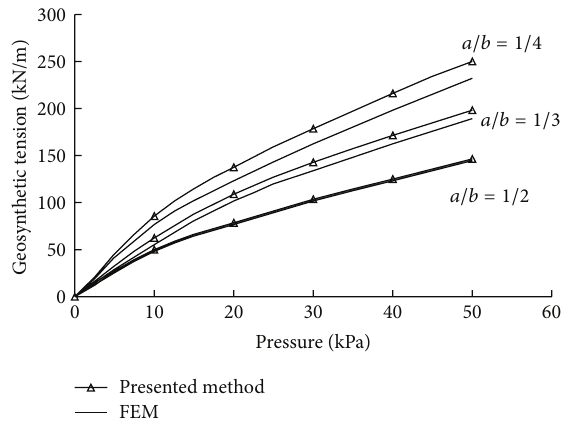
Figure 15: Comparison of geosynthetic tensions calculated by FEM and presented